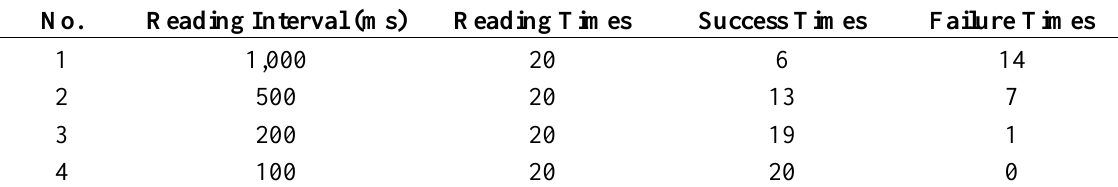
Table 5. RFID reading experiment